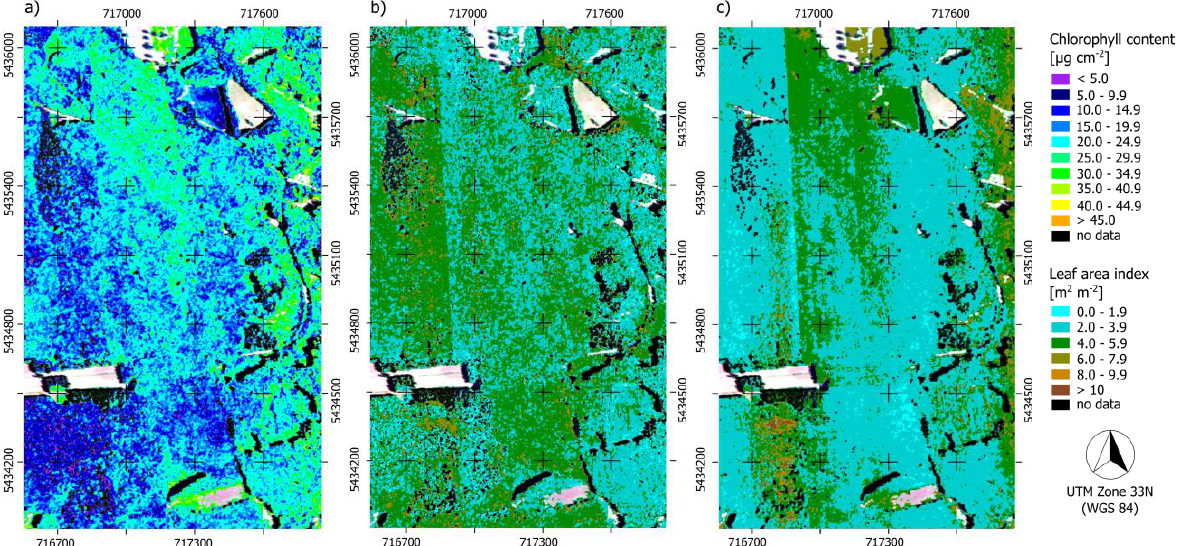
Figure 2. Estimated maps of leaf chlorophyll content using the continuum removal between 645 and 710 nm (a), leaf area index using the continuum removal between 680 and 800 nm (b), and leaf area index using all hyperspectral bands (c) as spectral inputs into the support vector regression estimating algorithm.